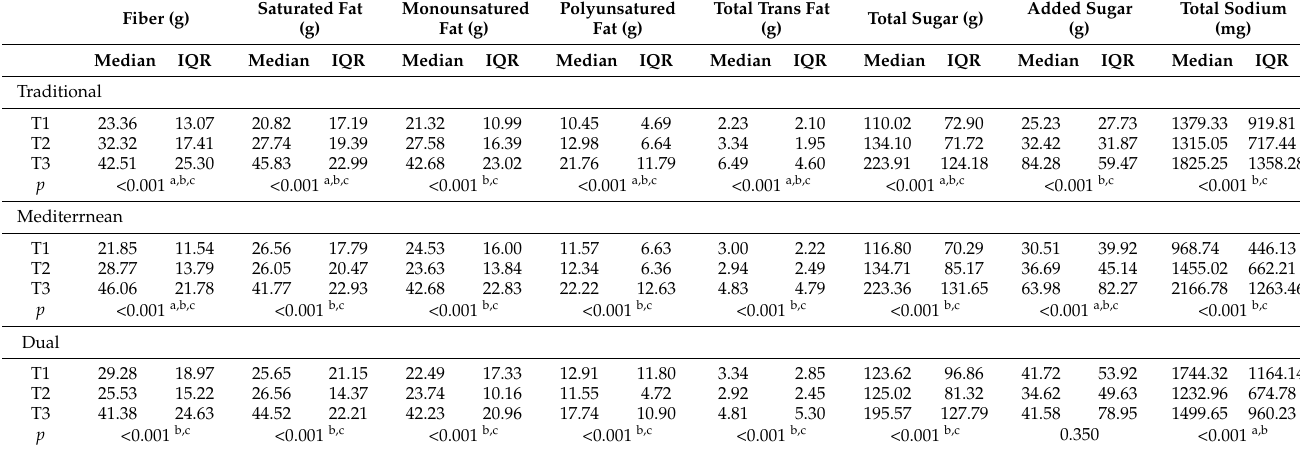
Table 6. Median nutrient intake according to the adherence tertiles to dietary patterns of patients hospitalized with CHF in Aracaju, SE,